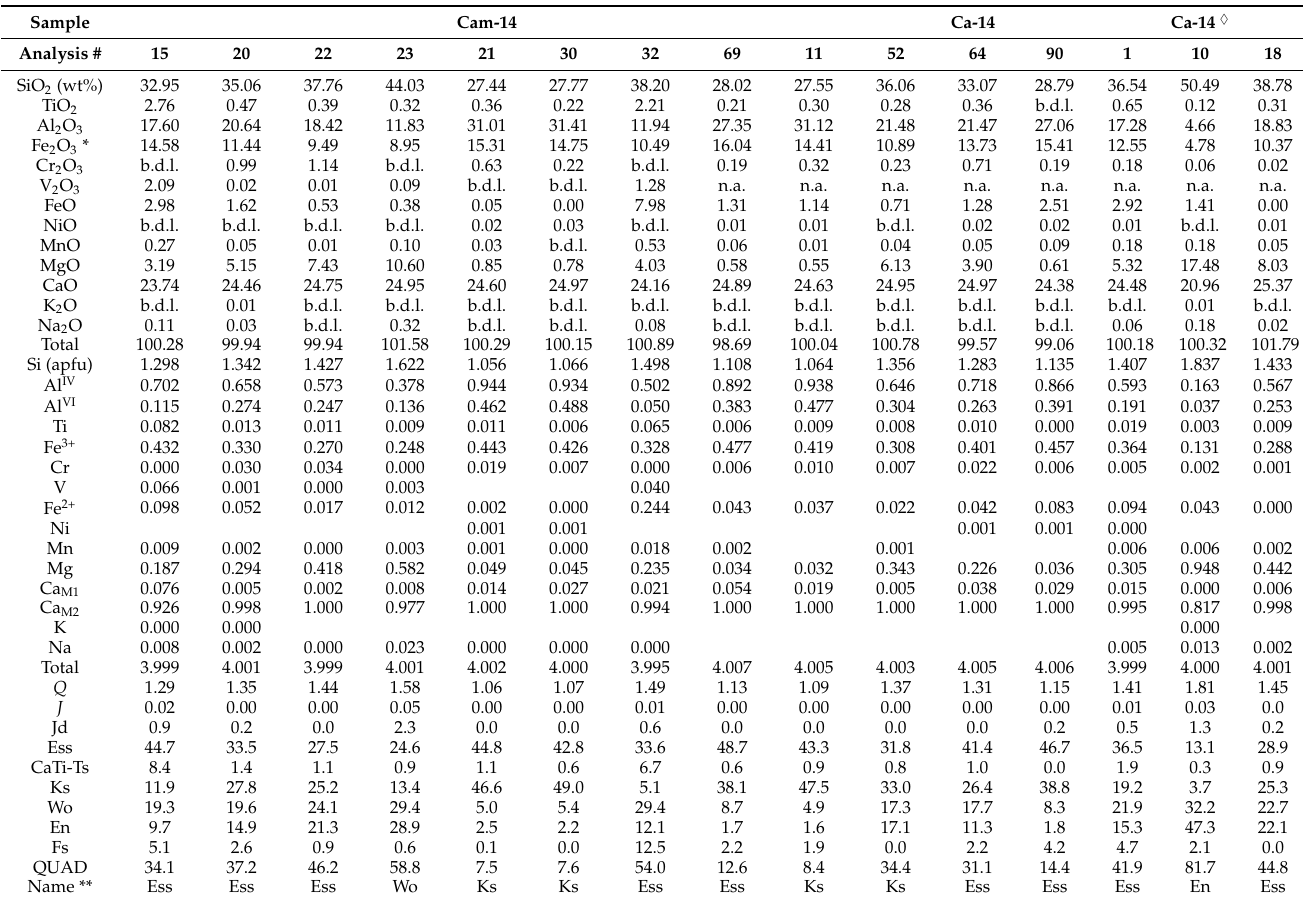
Table 1. Representative EPMA analyses, crystal chemistry and endmembers of